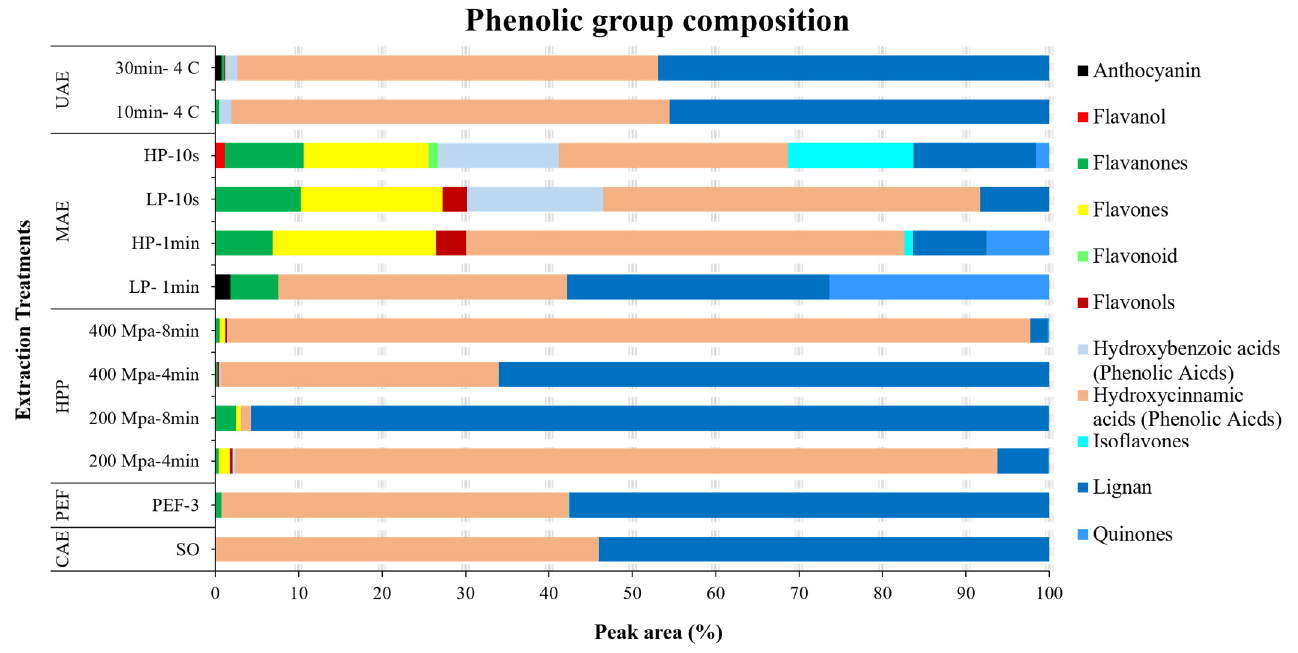
Figure 4. Composition of the phenolic groups identified in the extract obtained from buckwheat hull employing extraction strategies, including conventional-assisted extraction (CAE-SO (soak- ing)), pulsed electric fields (PEF-3 (PEF-24 kV-10 KJ-200 Hz-5 µ s)), high-pressure processing (HPP), microwave-assisted extraction (MAE), and ultrasound-assisted extraction (UAE) treatments.